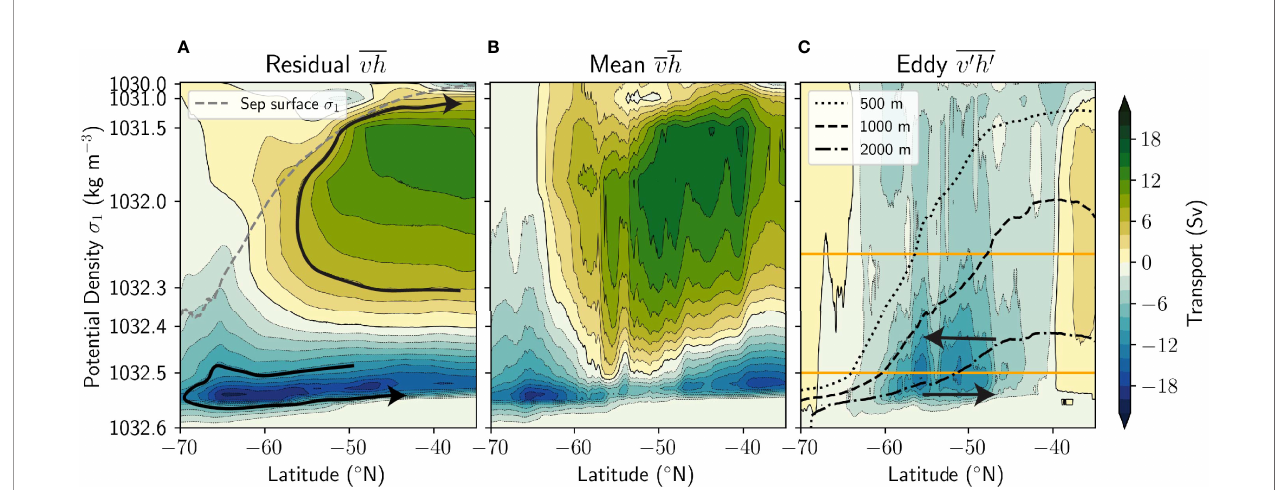
FIGURE 6 | Zonally averaged residual overturning streamfunction (A) , and its decomposition into mean (B) and eddy (C) terms, averaged over 10 years. Density ( s 1 ) coordinates are used – note the nonlinear vertical axis. Arrows indicate the direction of fl ows, which follow streamfunction contours. Positive streamfunction values indicate clockwise circulation. In panel A, the zonal and time averaged September surface density is shown to indicate the seasonally densest surface waters. In panel C, the orange lines indicate the upwelling arm density range, and the black lines the average densities at depths 500 m, 1000 m and 2000 m, as indicated in the legend.